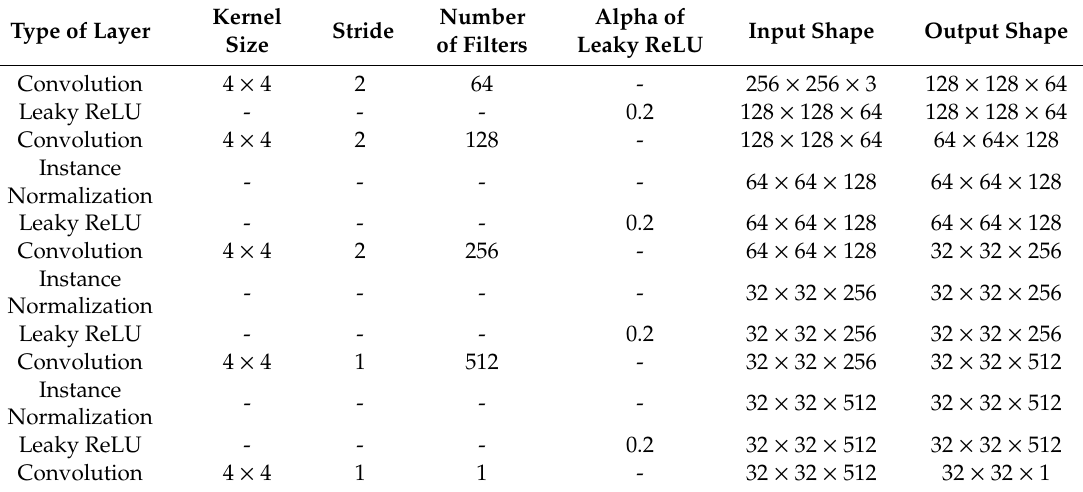
Table 2. Detailed description of the discriminator network used in our study (input and output shape is in format: height × width ×